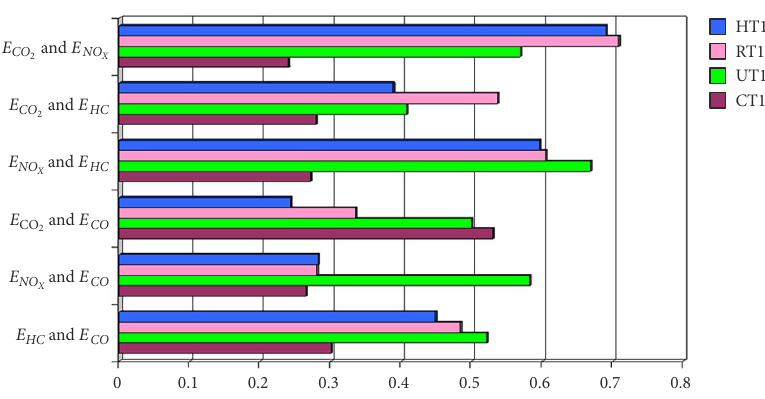
Figure 22. Coefficient of Kendall’s tau correlation t between the emission intensity of specific pollutants ( E CO , E NO , E CH , E CO ) in individual tests (CT1, UT1, RT1, 2 X